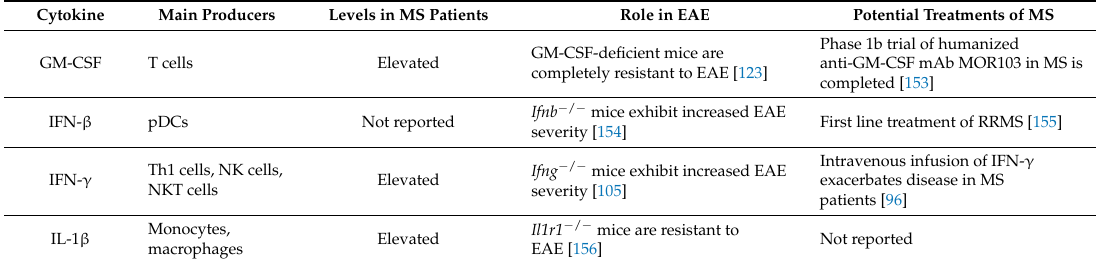
Table 1. Major cytokines contributing to the pathogenesis of multiple sclerosis (MS) and experimental autoimmune encephalomyelitis